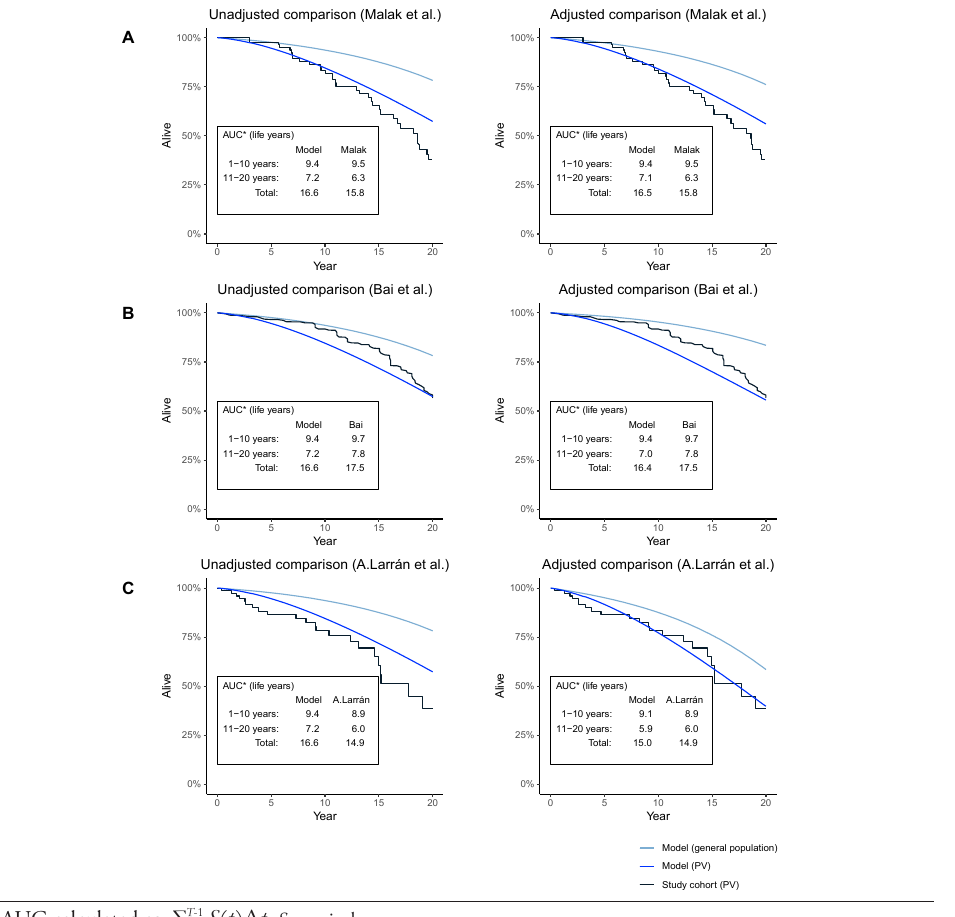
Figure 3. Comparison of Survival Curves Generated by Model and KM Curves of Real-Life